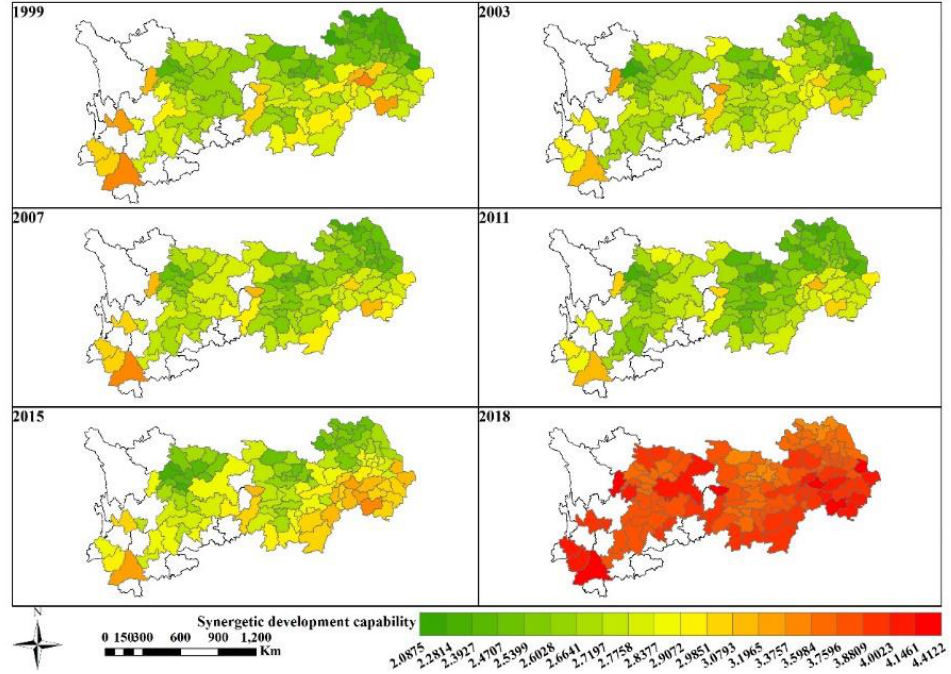
Figure 9. The synergetic development capability of the coupling system in 110 cities from 1999 to